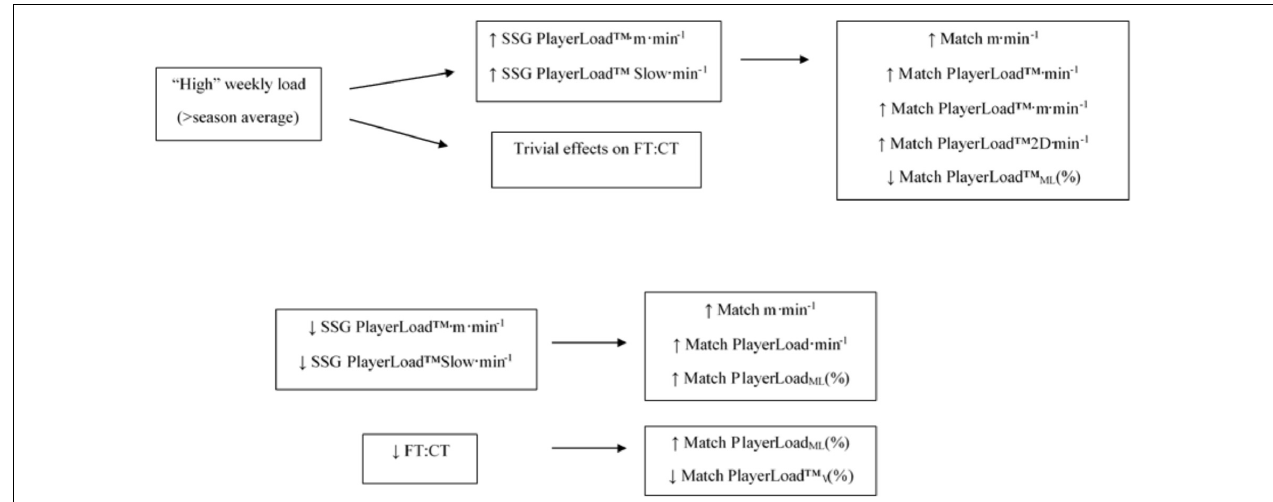
FIGURE 5 | Diagrammatical representation of the impact of high weekly load compared to low weekly load, on small-sided game; SSG accelerometer derived metrics and flight time:contraction time ratio; FT:CT, the related change in match activity profile due to increased small-sided game; SSG activity profile and the impact of suppressed small-sided game; SSG activity profile and flight time:contraction time; FT:CT on subsequent match activity